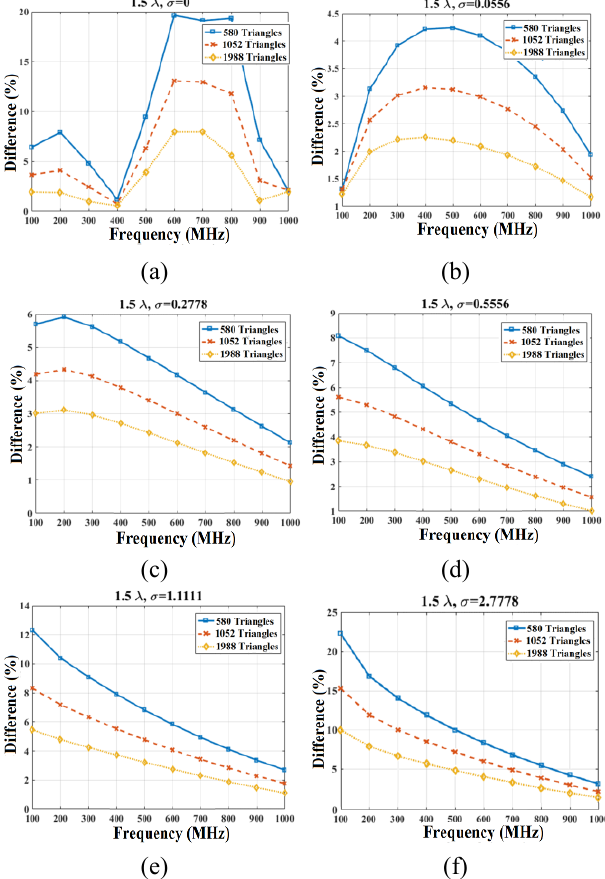
Figure 15: RCS difference percentage between MoM and SFIE in wideband for (a) 𝜎 =0 (b) 𝜎 =0.0556, (c) 𝜎 =0.2778, (d) 𝜎 =0.5556, (e) 𝜎 =1.1111, (f) 𝜎